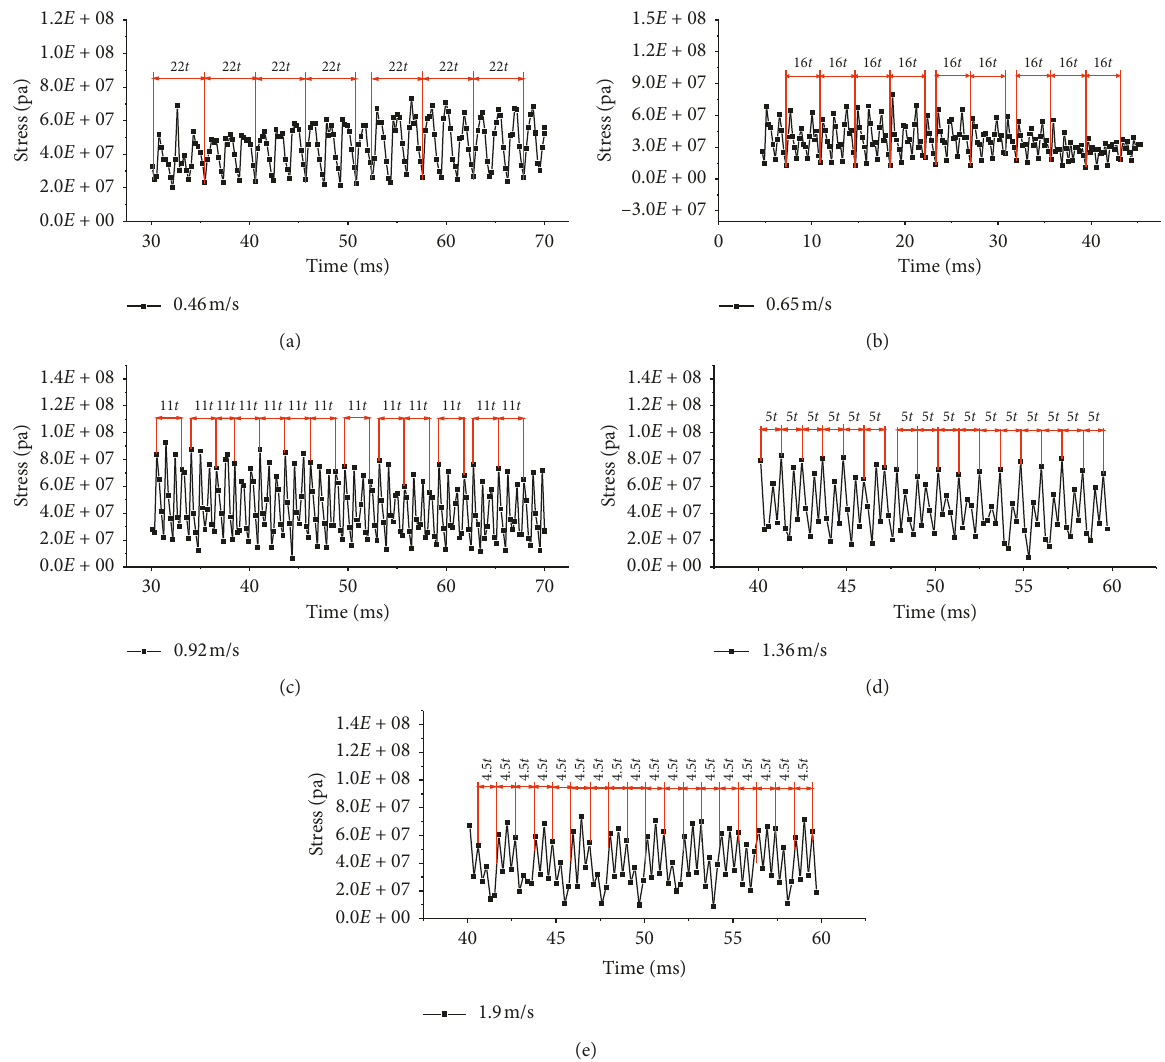
Figure 11: Stress fluctuation cycle period at different cutting speeds ( α (c) v 0.92m/s; (d) v (cid:31)